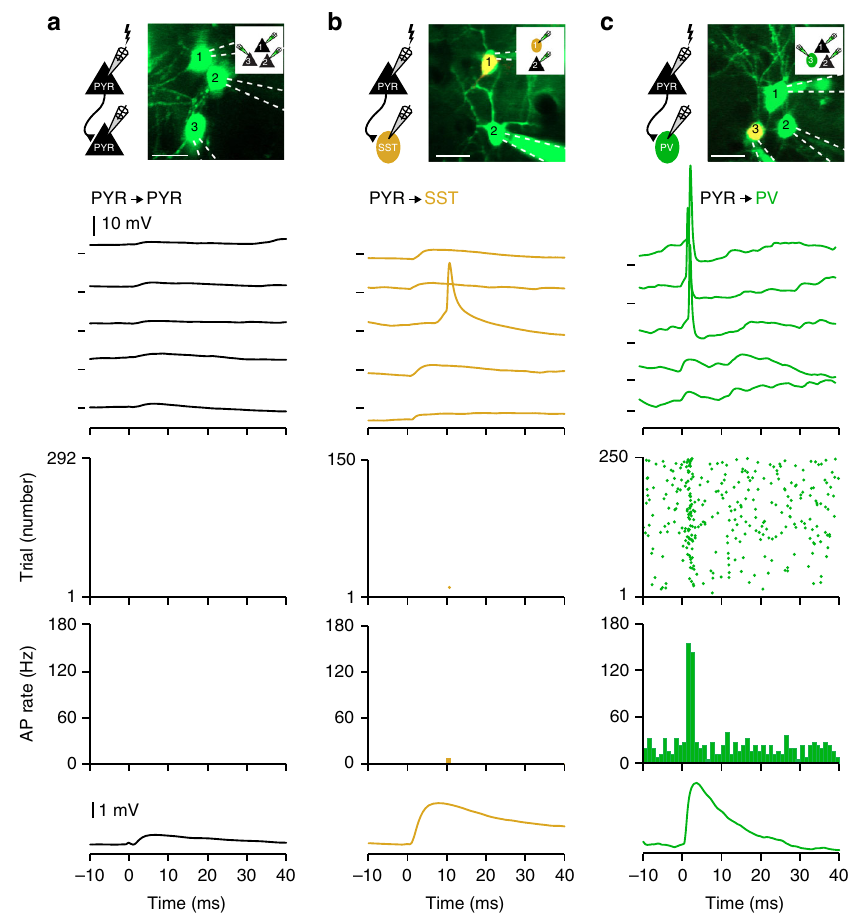
Fig. 2 Single u EPSPs trigger action potentials in parvalbumin-expressing GABA-ergic neurons. a From top to bottom: in vivo Z -stack image and cartoon schematic showing experimental setup of whole-cell recordings from three PYR neurons, example V m traces, action potential raster plot, peristimulus time histogram, and average unitary excitatory postsynaptic potential ( u EPSP) in a connected, postsynaptic neuron in response to a single presynaptic AP in a neighboring PYR neuron (time of AP = 0 ms). APs were evoked during depolarized network activity (UPstate). b Same as a , but for an example SST neuron receiving an excitatory synaptic input from a neighboring PYR neuron. c Same as b , but for an example postsynaptic PV neuron. Note, u EPSPs trigger reliable and temporally precise APs in PV neurons. Scale bars, 20 µ m. V m marks in a – c show − 50.0